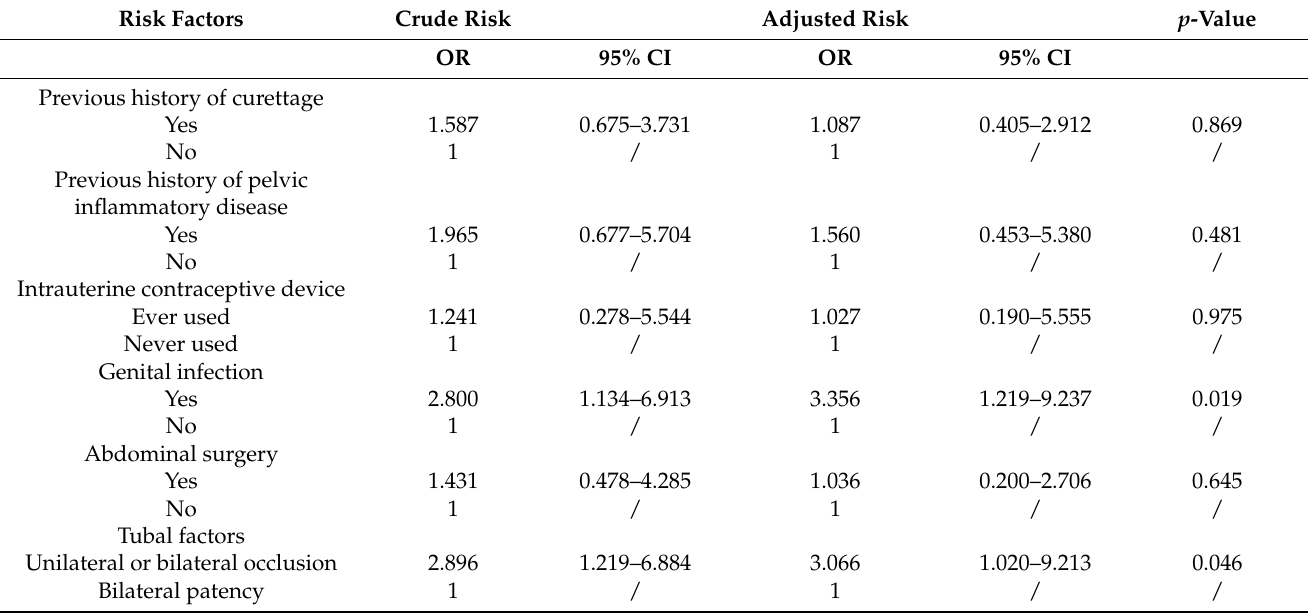
Table 2. Odds ratio and 95% confidential interval (CI) for CE associated with covariates.